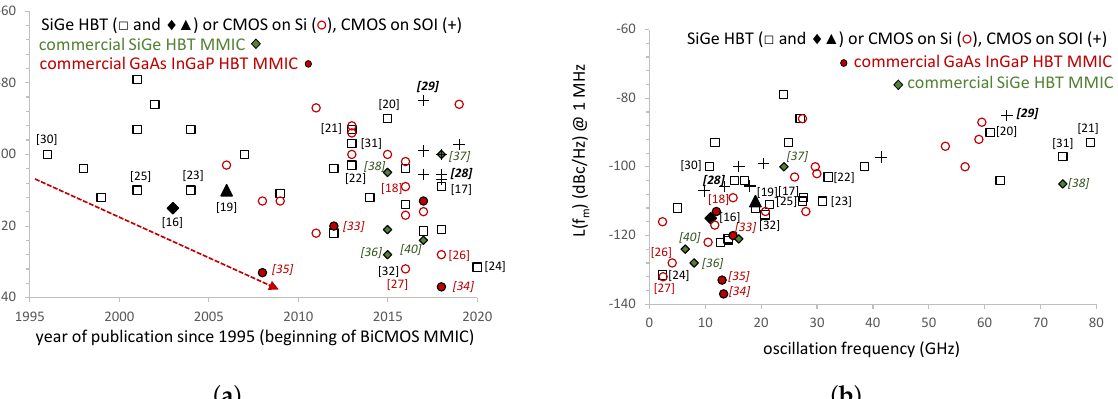
Figure 8. Evolution of Leeson’s figure of merit ( a ) versus the year of publication (timeline) and ( b ) versus the oscillation frequency. Some references used in the paper are noted close to the associated symbol